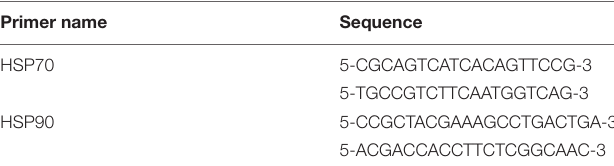
TABLE 1 | Primers sequences for PCR for the heat shock protein gene